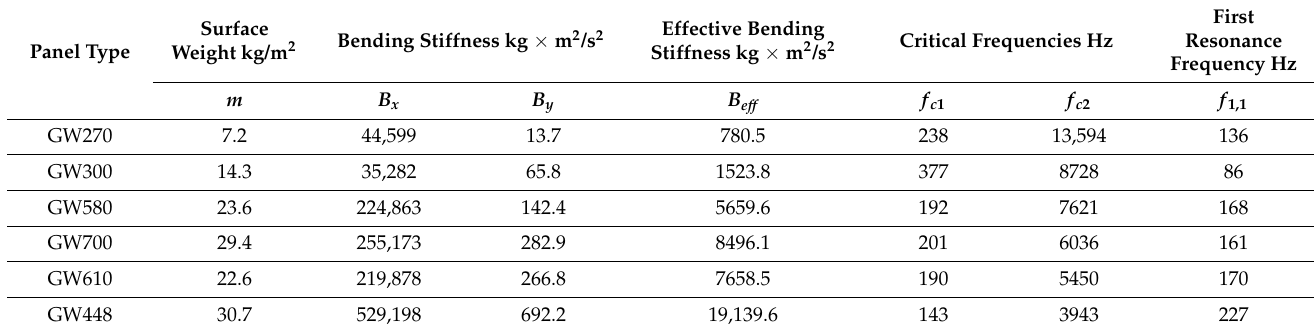
Table 2. Calculated properties of fluted (orthotropic) PVC panels.